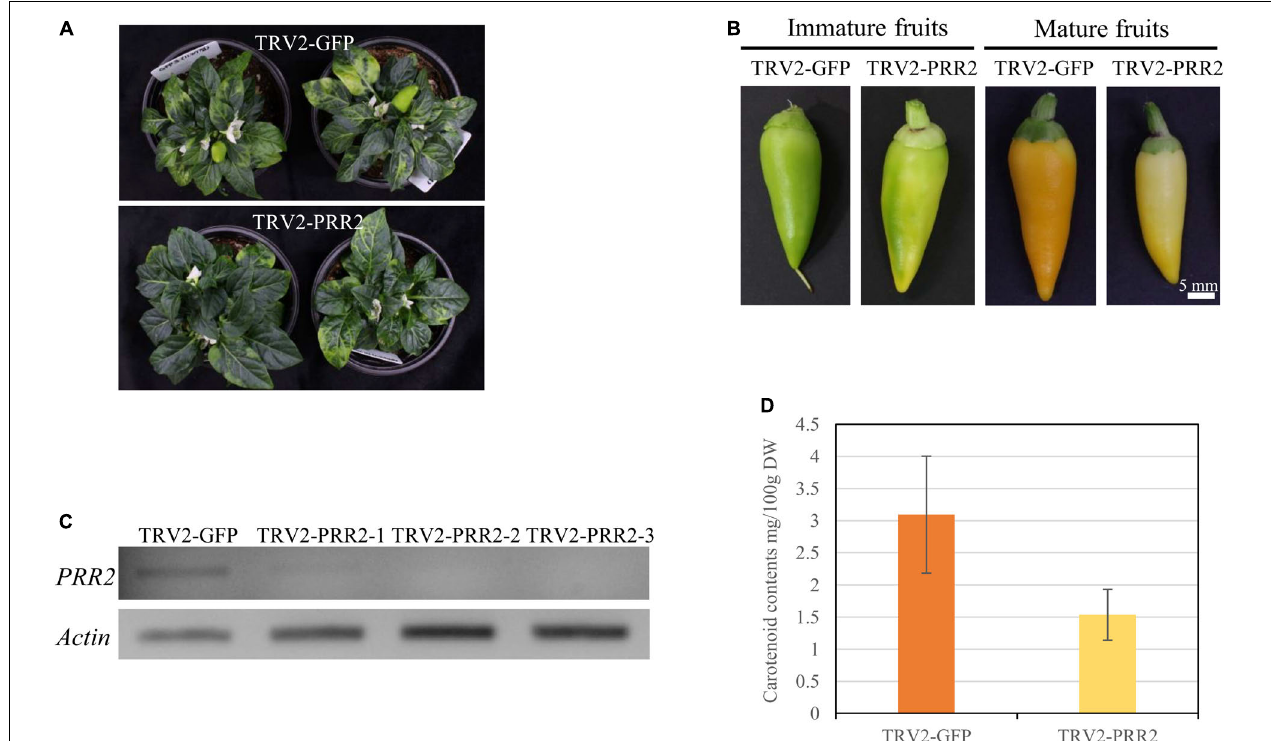
FIGURE 5 | VIGS of PRR2 in MY. (A) Phenotypes of TRV2-GFP-inoculated MY (top) and TRV2-PRR2-inoculated MY (bottom) plants at 60 days after inoculation (DAI). (B) Effect of the VIGS of GFP and PRR2 on the color of immature and mature fruit. Scale bar, 5 mm. (C) Expression analysis of PRR2 using RT-PCR. Three biological replicates of PRR2 -silenced fruits were used. Actin served as a control. (D) Total carotenoid contents of TRV2-GFP- or TRV2-PRR2-inoculated MY fruits. The standard deviation of carotenoid contents of TRV2-GFP- or TRV2-PRR2-inoculated MY fruits were 0.909484 and 0.396838, respectively, with the p- value of 0.09078 using Student’s t -test. TRV2-GFP was used as a vector